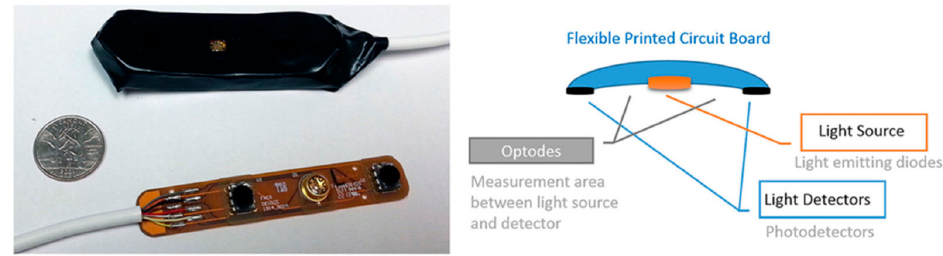
Figure 17. A small scalable example of fNIRS sensor pad. The size shows the convenience of fNIRS to not interfere with everyday life. This model contains two optodes. (Reprinted from